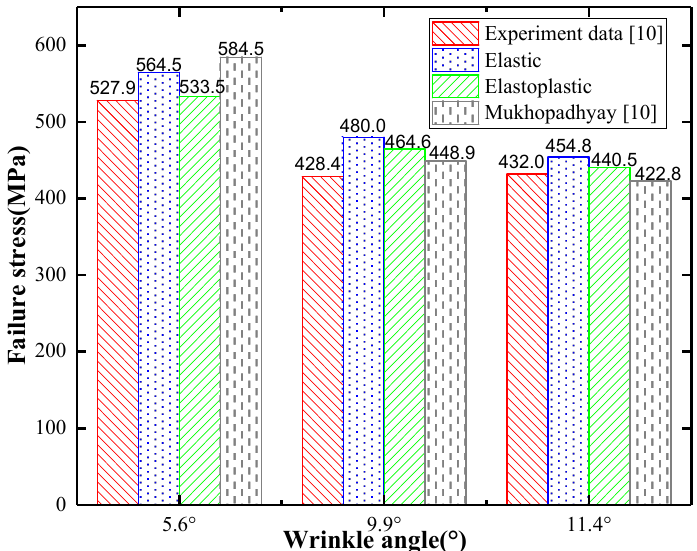
Figure 13. Compressive strength comparison for the three models and test results.